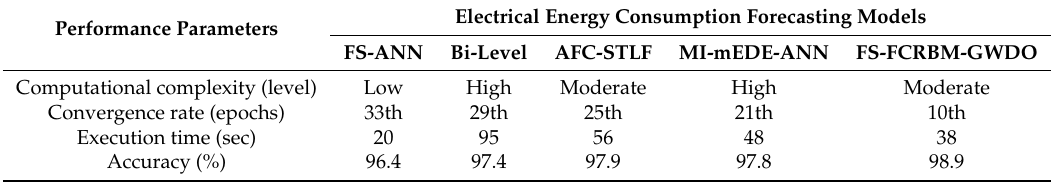
Table 5. Evaluation of the proposed FS-FCRBM-GWDO framework and the benchmark frameworks such as FS-ANN, Bi-level, AFC-ANN, and MI-mEDE-ANN in terms of computational complexity, execution time, convergence rate, and